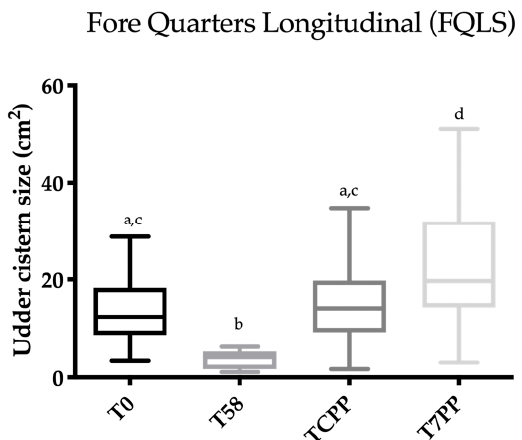
Figure 4. Scatter box plot showing the median, minimum and maximum values of the ultrasonographic udder cistern size between T0 vs. T58 vs. T colostrum production phase (TCPP) vs. T 7 days post-partum (T7PP) for the fore quarter longitudinal section (FQLS). Legend: a ≠ b ≠ c ≠ d: p < 0.05.